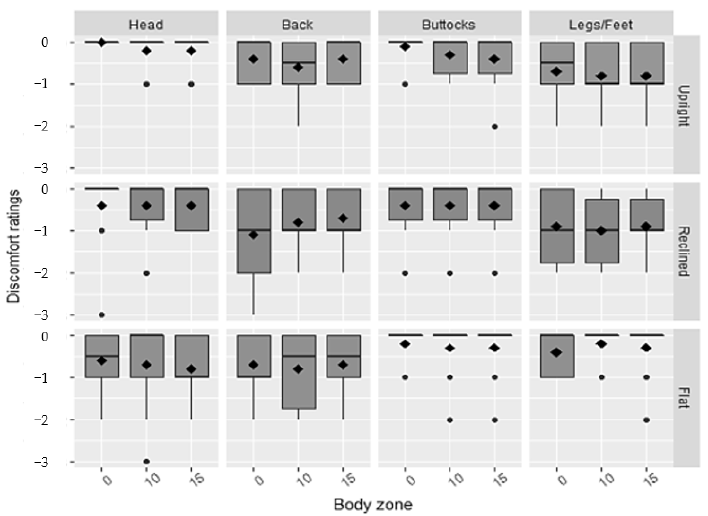
Figure 6. Boxplot with different body part comfort ratings for the upright, reclined and flat seat conditions over time. The diamond shapes indicate the mean and circles indicate outliers. Table 2. ANOVA and t -test paired comparison for dependent variables related to comfort and relax level in the seat for the upright (Up), reclined (Rc) and flat (Fl) conditions. * Symbol indicates a significant effect ( p <